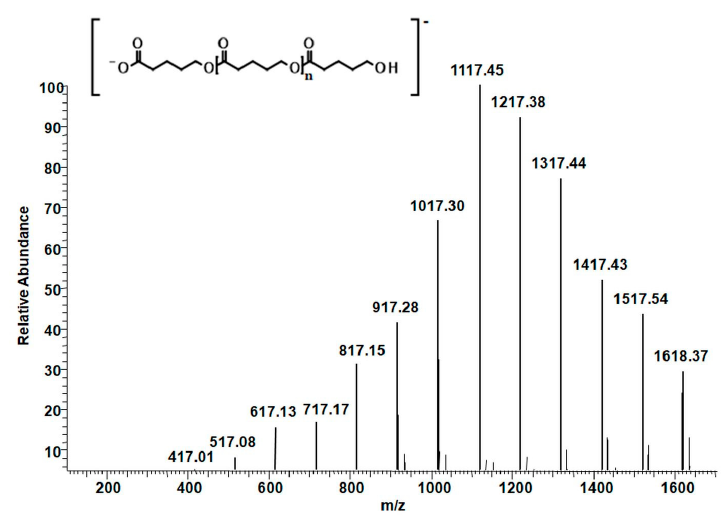
Figure 7. ESI ‐ MS n spectrum (negative ion mode) of poly( δ ‐ valerolactone) precursor ion at m/z 917 and the respective parent ions with different chain length (MS 2 –MS 9 ), (Sample 1, Table 1).